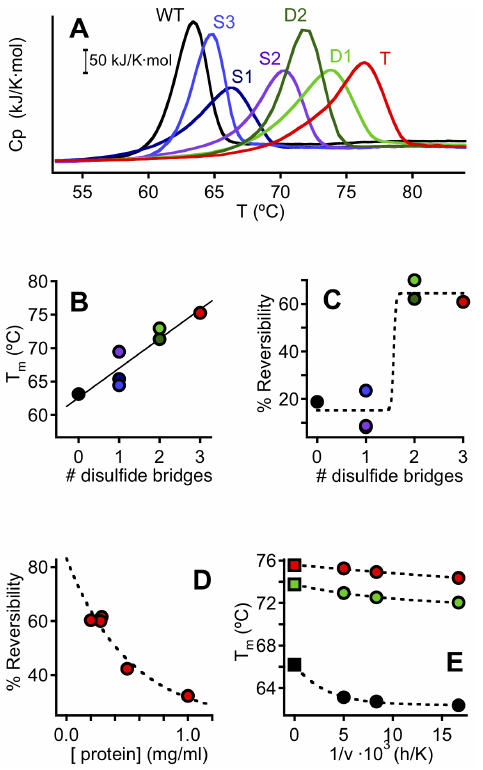
Figure 5. Differential scanning calorimetry (DSC) of the thermal denaturation of wild-type phytase and the disulfide variants. A) Representative DSC profiles at a protein concentration of 0.5 mg/mL and a scan rate of 200 degrees/hour. B) Plot of transition temperature (derived from the results in panel A) versus number of engineered bridges. C) Plot of degree of reversibility of the thermal denaturation process versus the number of engineered bridges. The degrees of reversibility shown were derived from DSC experiments performed with a protein concentration of 0.25 mg/mL, at a scanning rate of 200 u C /hour. In all cases, the first scan was stopped at 100 u C and a re-heating run was performed after letting the sample cool in the calorimetric cell. The degree of reversibility was calculated as the ratio between the maximum heat capacity values for the reheating and the first transitions after suitable chemical baseline correction. D) Degree of reversibility for the variant with three engineered bridges versus protein concentration. E) Scan-rate effect on the transition temperatures (circles) derived from DSC experiments. Extrapolation to 1/v=0 (i.e., to infinite scan-rate) should remove kinetic distortions associated to partial irreversibility (the squares at 1/v=0 actually represent the denaturation temperatures for equilibrium unfolding determined from model fitting to rate data). In panels B–E the colors refer to the different variant studied as specified in panel A. (Figures 6D,E) of the rate constants obtained at these two protein concentrations (equation 1 possibly breaks down at lower protein concentrations: see Figure S2).